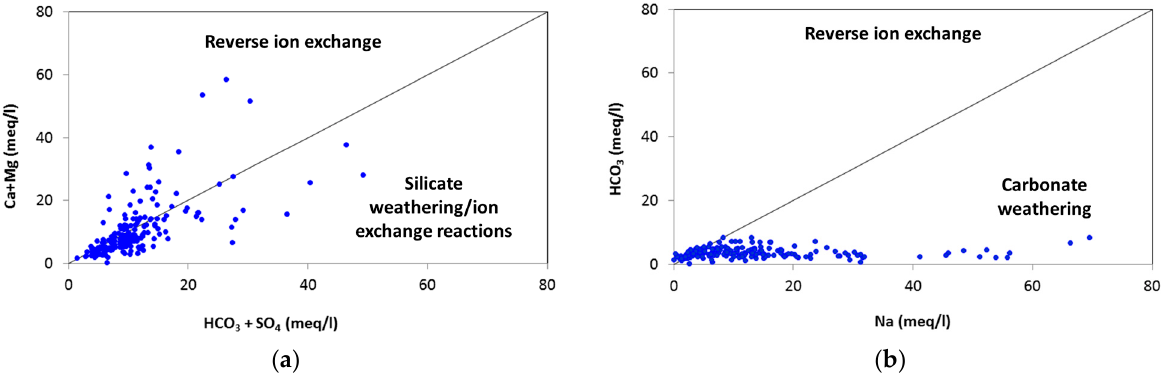
Figure 6. Plots of Ca 2+ + Mg 2+ vs. HCO 3 − + SO 42 − and Na vs. HCO 3 − values for groundwater samples Figure 6. Plots of ( a ) Ca 2+ + Mg 2+ vs. HCO 3 − + SO 4 2 − and ( b ) Na vs. HCO 3 − values for groundwater in the study area. samples in the study